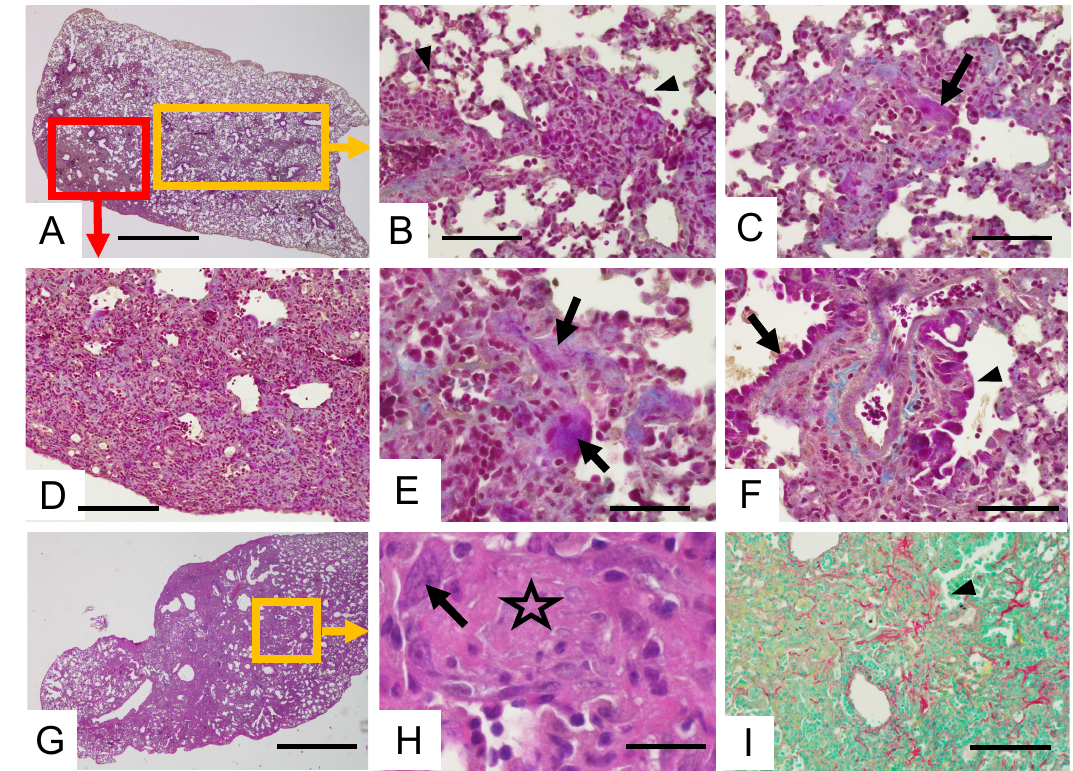
Figure 4. Lung histopathology in the BLM-AE groups. Illustration of lung lesions observed in different mice after double-dose BLM intratracheal instillations. ( A ) Subpleural dense cellular and fibrotic remodeling observed by Masson’s staining. Scale bar 2000 μ m. ( D ) Magnification of the red framed area in A, scale bar 200 μ m. ( B , C , E , F ) Magnification of the yellow framed area in A showing mononuclear cell infiltration. ( B ) Perivascular mononuclear cell infiltration (arrowheads). Scale bar 100 μ m. ( C , E ) Acute alveolar cell lesions (arrows) and blue matrix deposits. ( C ) Scale bar 100 μ m, ( E ) scale bar 150 μ m, ( F ) “Reactive” airway cells (arrowhead) compare to normal cells (arrows). Scale bar 150 μ m. ( G – I ) Subacute lesions in a dense remodeled area. ( G ) Masson’s staining. Scale bar 200 μ m. ( H ) Magnification of the yellow framed area in G showing an interalveolar bud (star) layered by atypical epithelial cells (arrow). Scale bar 50 μ m. ( I ) Red-stained intercellular collagen deposits (arrowhead) within the cellular infiltration (Sirius red/fast green staining, scale bar 100 μ m).